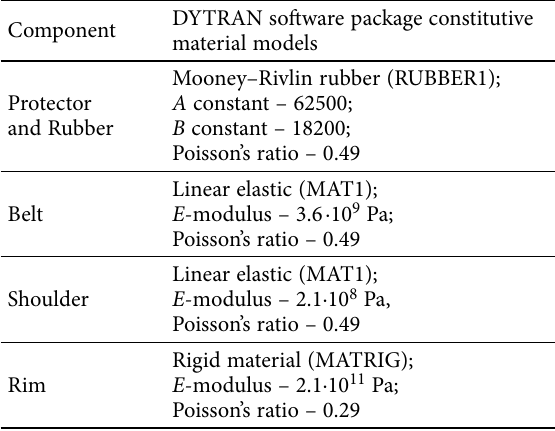
Fig. 3. Tire boundary conditions scheme: 1 – Lagrangian elements; 2 – Eulerian elements (water film and void); 3 – tire inflation air pressure; 4 – weight of quarter of vehicle; 5 – grounded damper element; 6 – rotation of the tire; 7 – linear movement of rigid road and water film